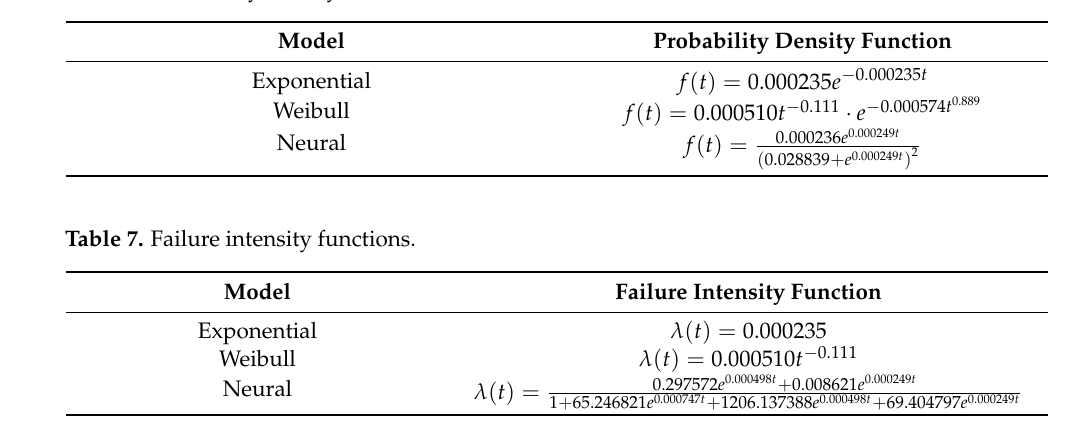
Table 6. Probability density functions.